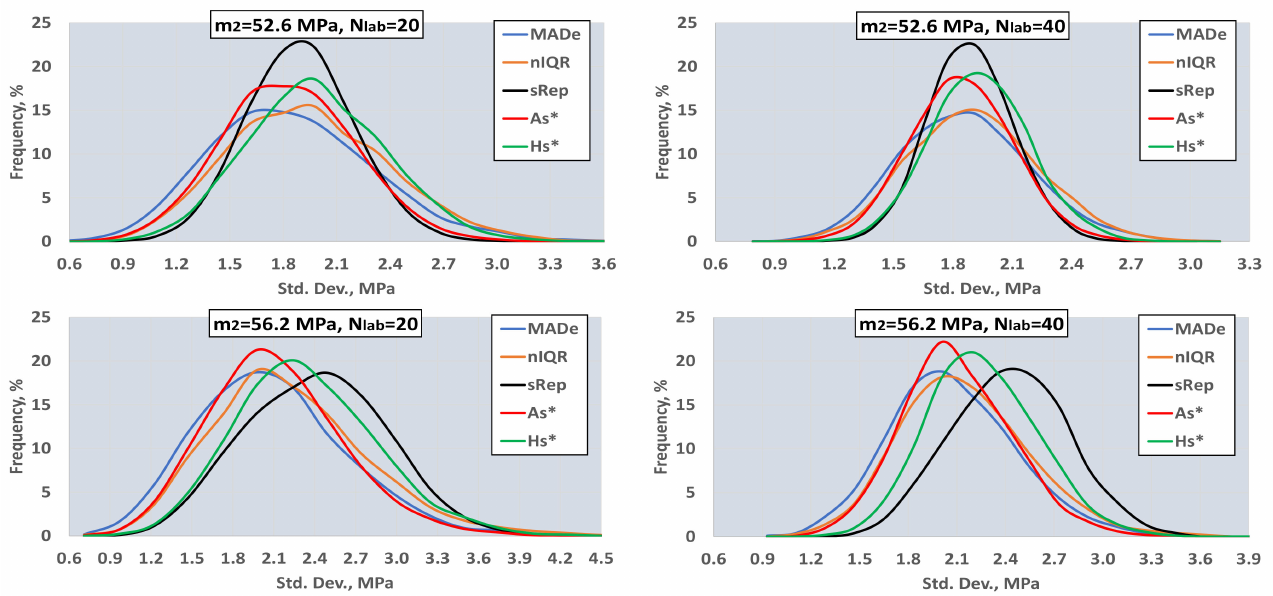
Figure 7. Distribution of the population standard